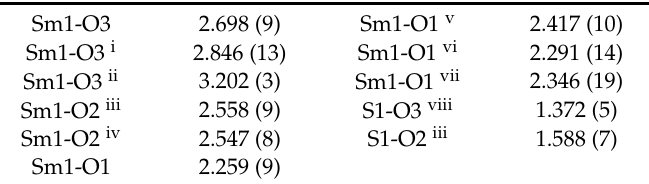
Table 3. Main bond lengths (Å) of Sm 2 O 2 SO 4